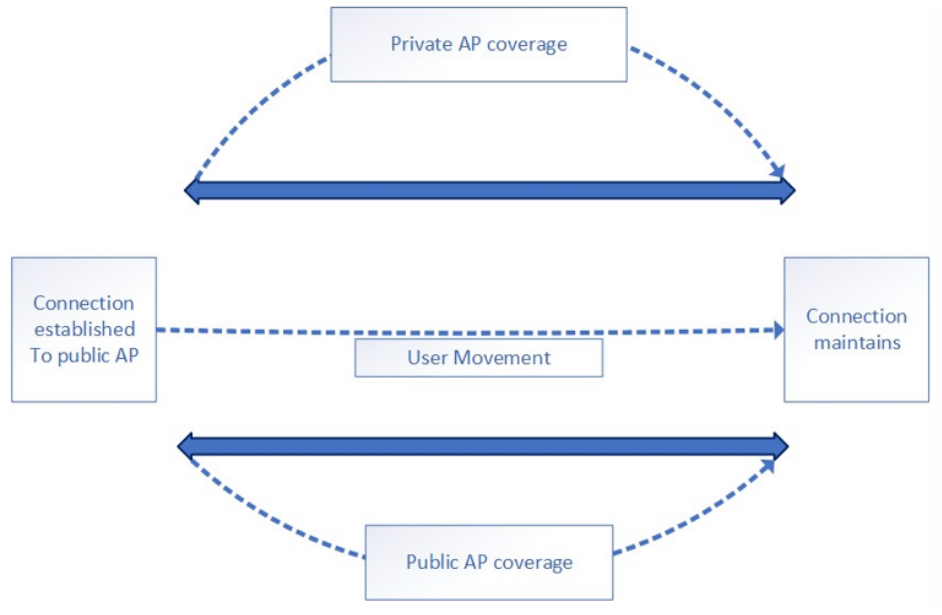
Figure 1. Mobile user connectivity behavior with access